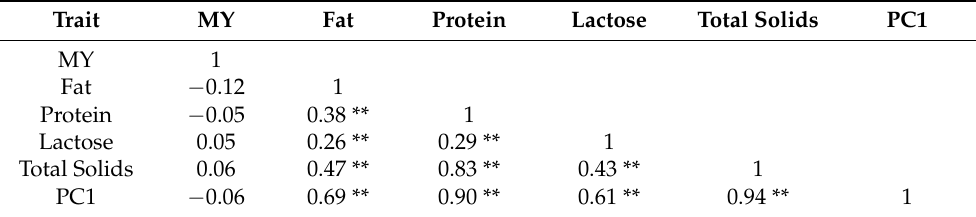
Table 2. Phenotypic Spearman correlation among milk performance